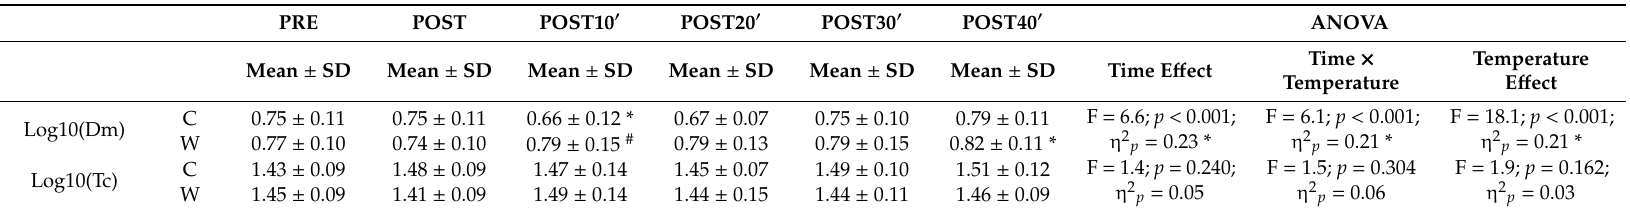
Table 1. Two-way ANOVA for the comparison of muscle displacement and contraction time changes over time, according to water